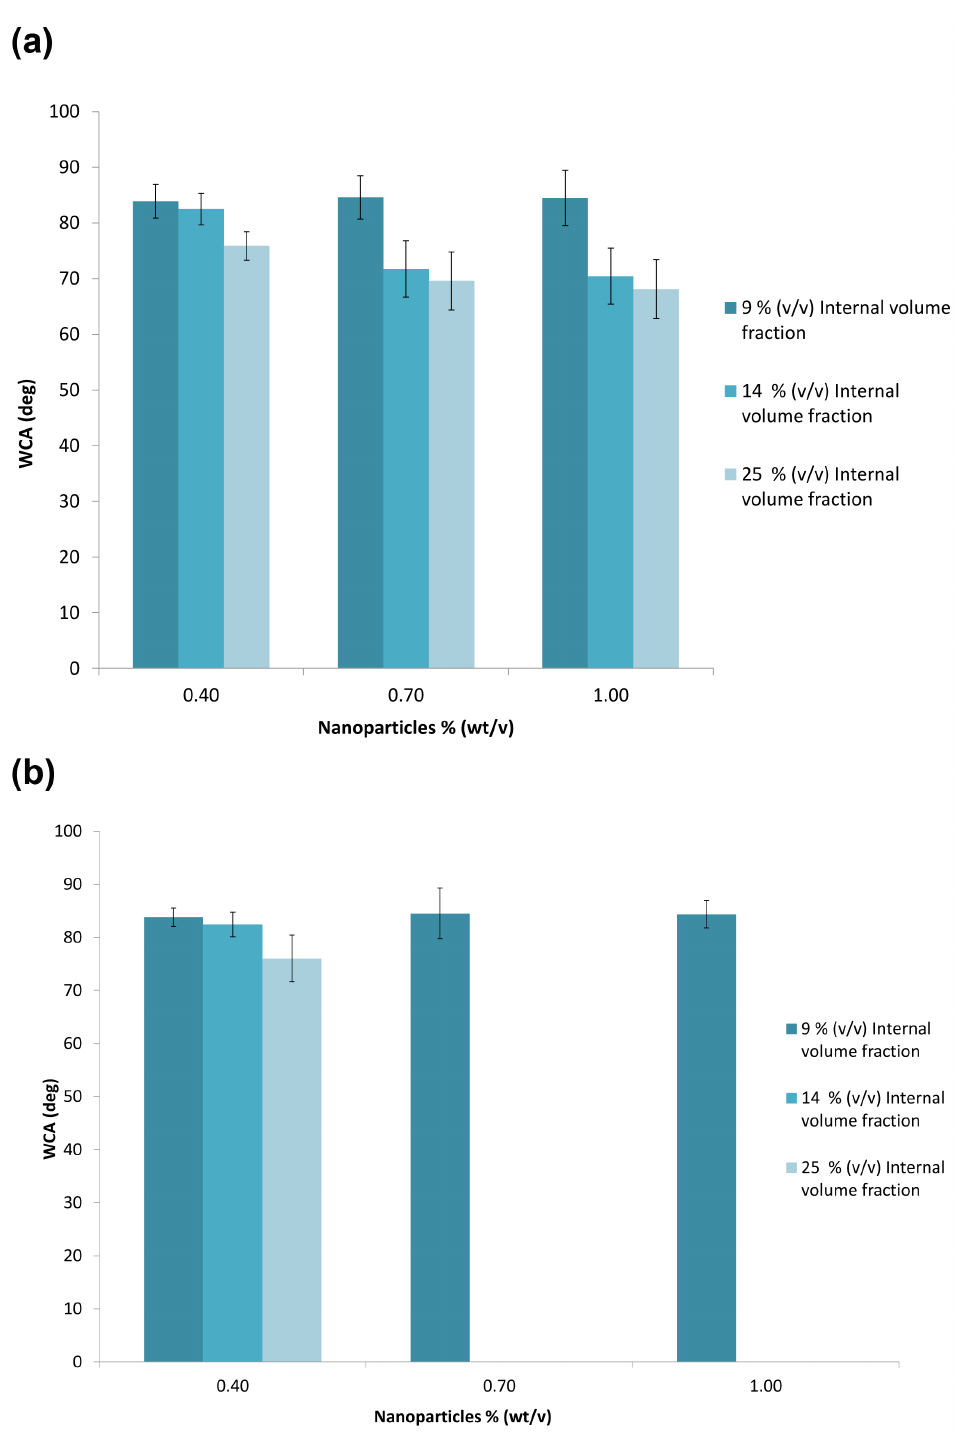
Figure 7. Water contact angle (WCA) measurements on functional membranes with gelation of internal phase. Each series represents an internal volume fraction as displayed in the legend. Horizontal axis represents particle concentration in % (w/w). ( a ) Immediately after deposition of water droplets on the surface, ( b ) 15 seconds after water droplet deposition on the surface. On membranes with 0.7% (w/v) nanoparticle stabilization, the water contact angle decreased to 0 for 14% (v/v) and 25% (v/v) internal volume fractions. Data indicates the average of at least three observations with corresponding standard deviations. doi:10.1371/journal.pone.0088125.g007 number of gelled domains smaller with increasing W . Smaller Salt release was measured from composites upon incubation in number of hydrophilic domains will cover less of the top surface of water, where K + ion concentration was measured at 15, 50, 120 the composite and result in stable water droplets in time. and 240 minutes (Table S2). Figure 8 shows that K + ion release